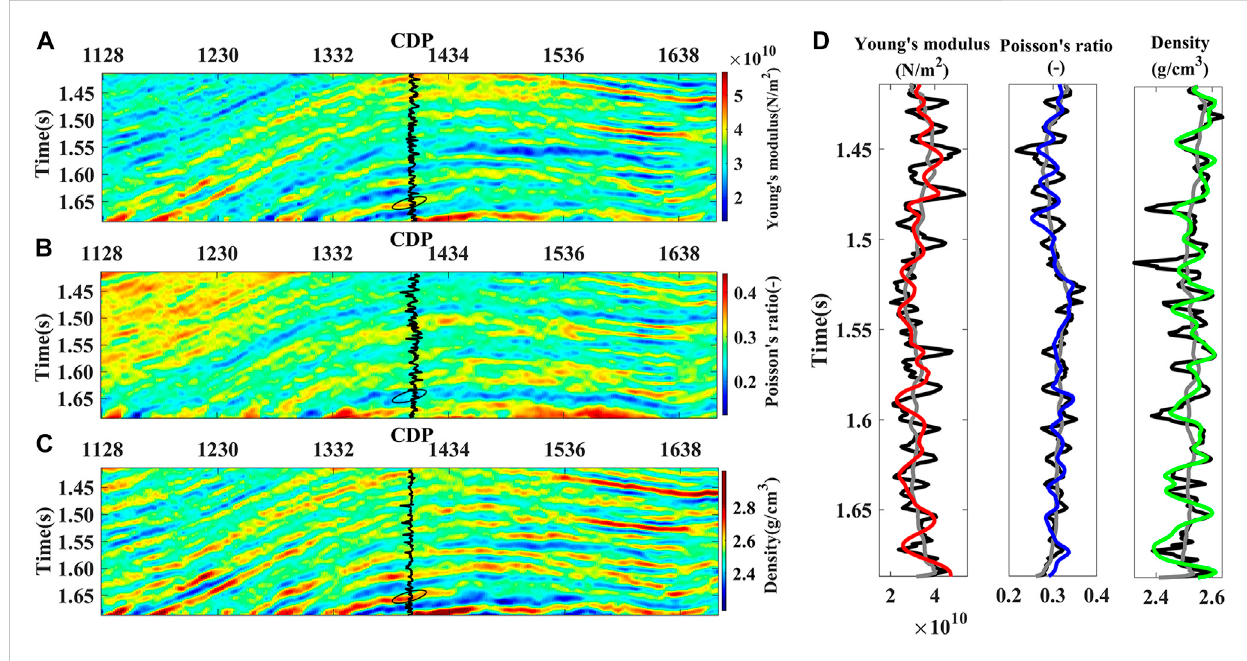
FIGURE 11 Inversion results for (A) Young ’ s modulus (B) Poisson ’ s ratio (C) Density. (D) Comparison among the true logs (black), initial models (gray), and inversion results (red, blue, and green) at the well location. The black ellipse indicates the target